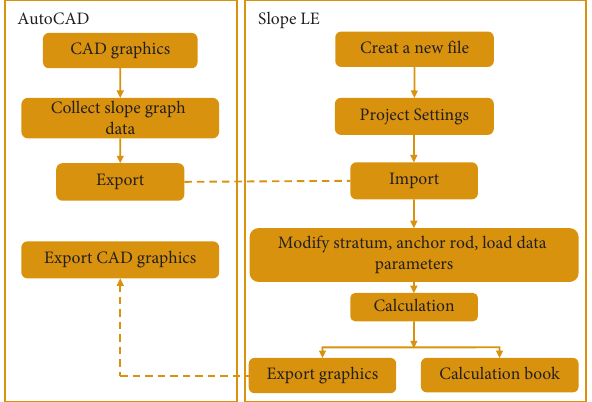
Figure 17: CAD and SlopeLE using flow